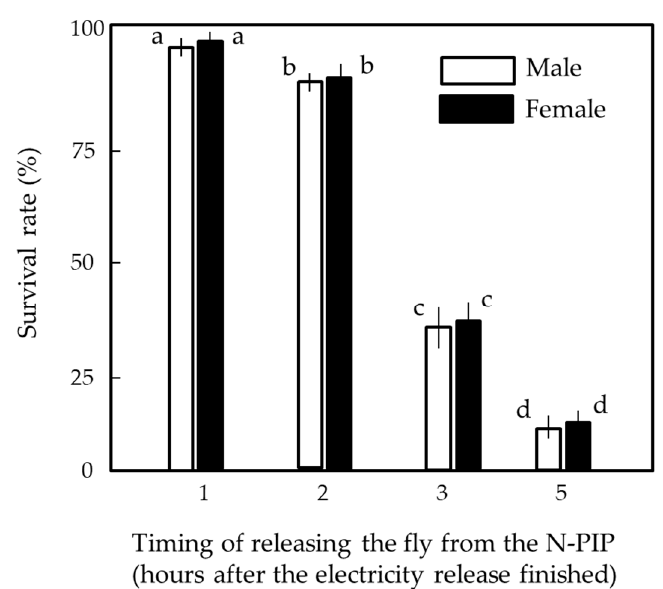
Figure 8. Relationship between the time of release of 7-day-old female houseflies from the N-PIP charged at − 8 kV and survival. Fly mortality was determined at 5 days after release from the N-PIP. We used 20 insects for each sex and hour, and means ± standard deviation were calculated from five experimental replicates. Letters (a–d) in each vertical column indicate significant differences ( p < 0.05) according to Tukey’s test.